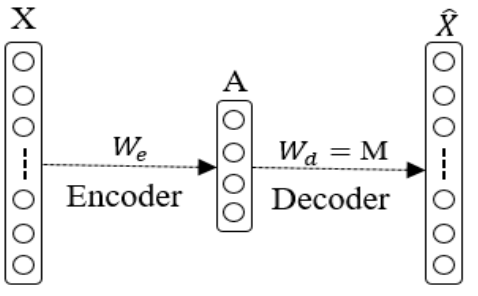
Figure 1. Supervised approach of HSU using autoencoder.